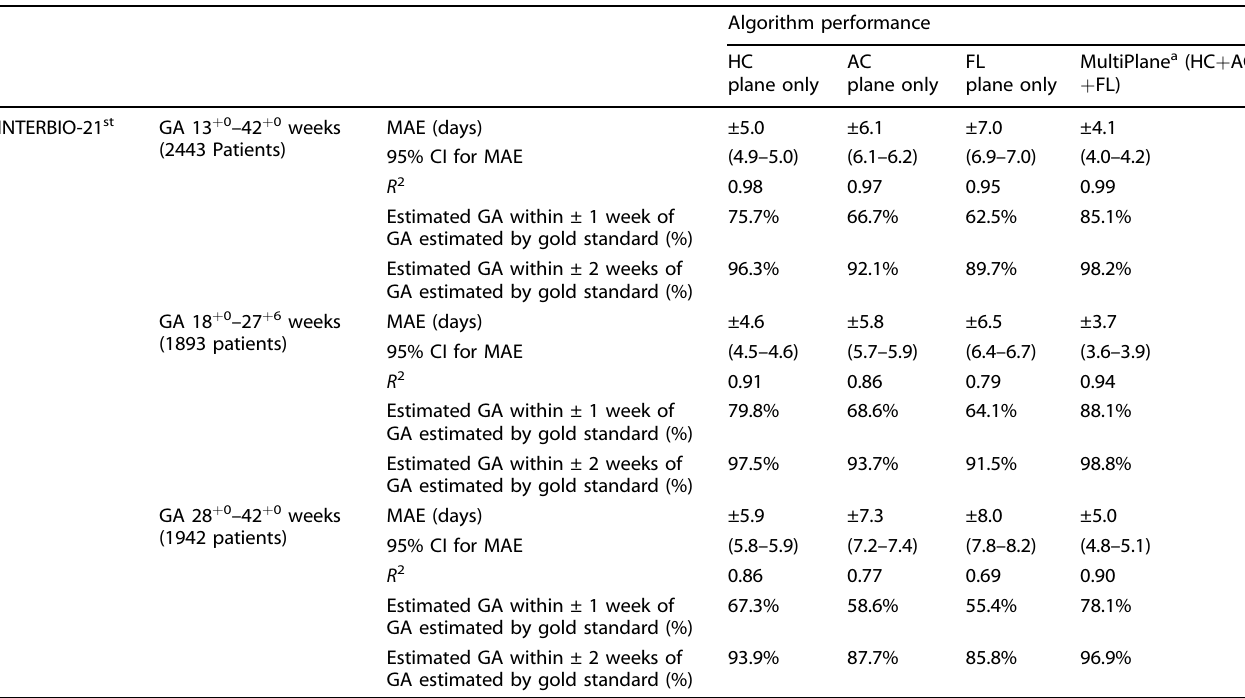
Table showing the performance per plane (HC only, AC only, FL only, and MultiPlane) in the INTERGROWTH-21st test set (2a) and the INTERBIO-21st external validation set